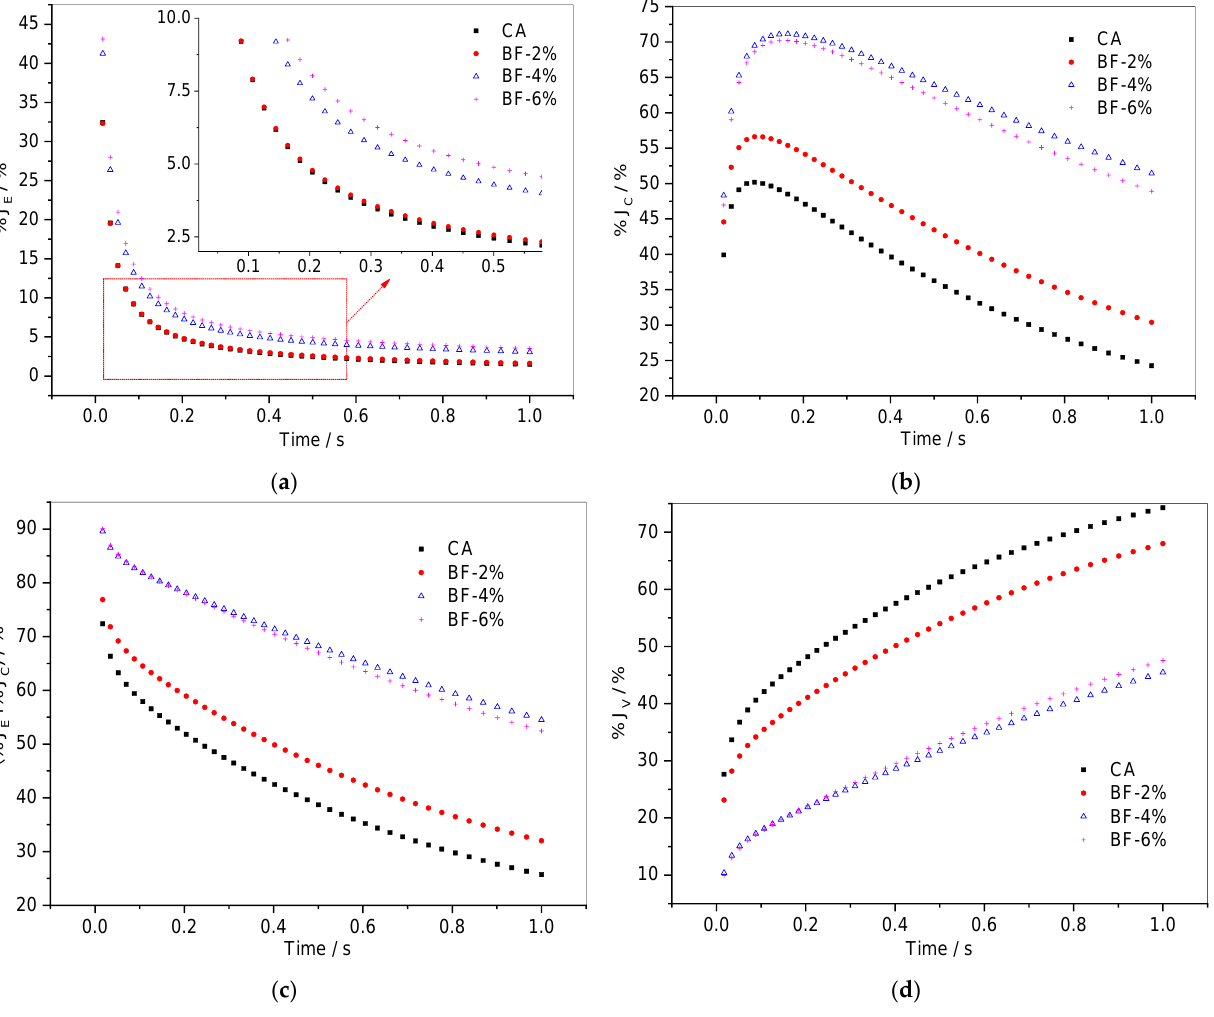
Figure 11. Evolution of ( a ) % J E , ( b ) % J C , ( c ) (% J E + % J C ) and ( d ) % J V versus time for composites with brucite fiber in the 50th cycle.